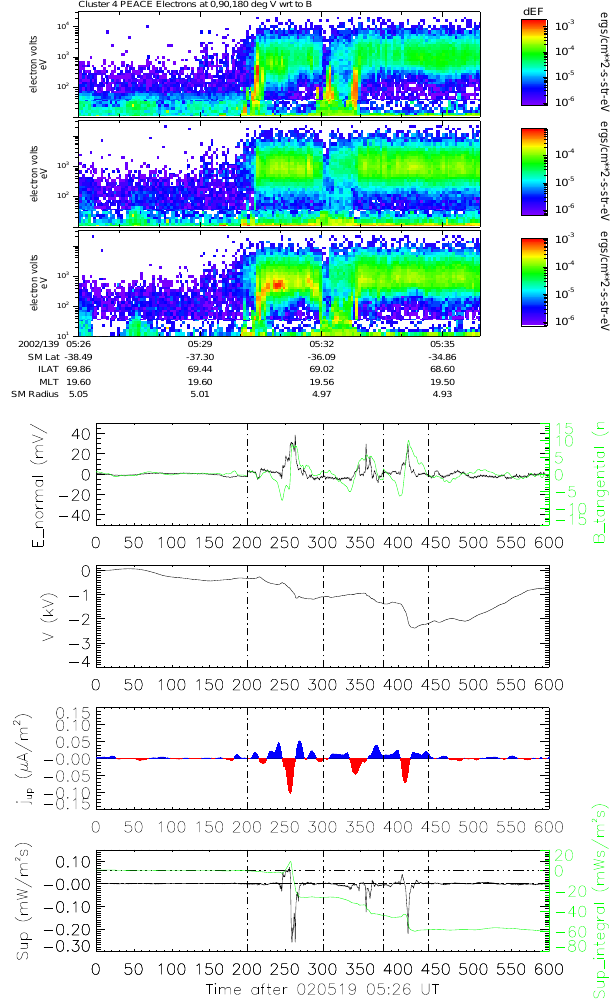
Fig. 3. 19 May 2002, s/c 4. The same panels as in Fig.